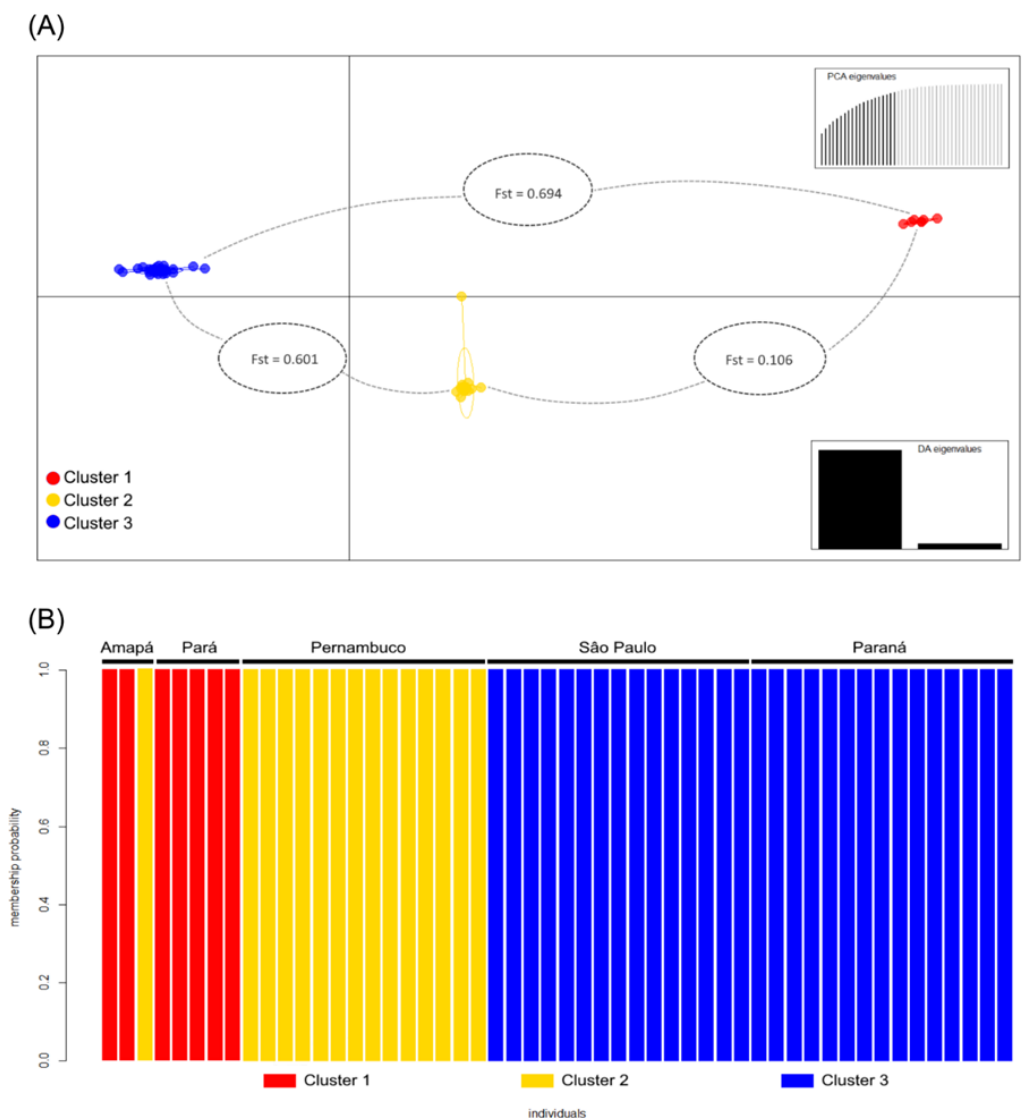
Figure 3. Inference of the number of clusters obtained in the Discriminant Analysis of Principal Components (DAPC) performed on the 3.329 SNPs dataset from Pseudobatos percellens . ( A ) DAPC scatterplot distinguishing between the three genetic clusters and F ST pairwise values detected be- tween them. The Principal Component Analysis (PCA) and DA (Significance tests) eigenvalue representatives are highlighted in the inset. ( B ) Subdivision of the individuals based on the DAPC membership probabilities into three genetic clusters (k = 3). The same color for individuals indicates that they belong to the same